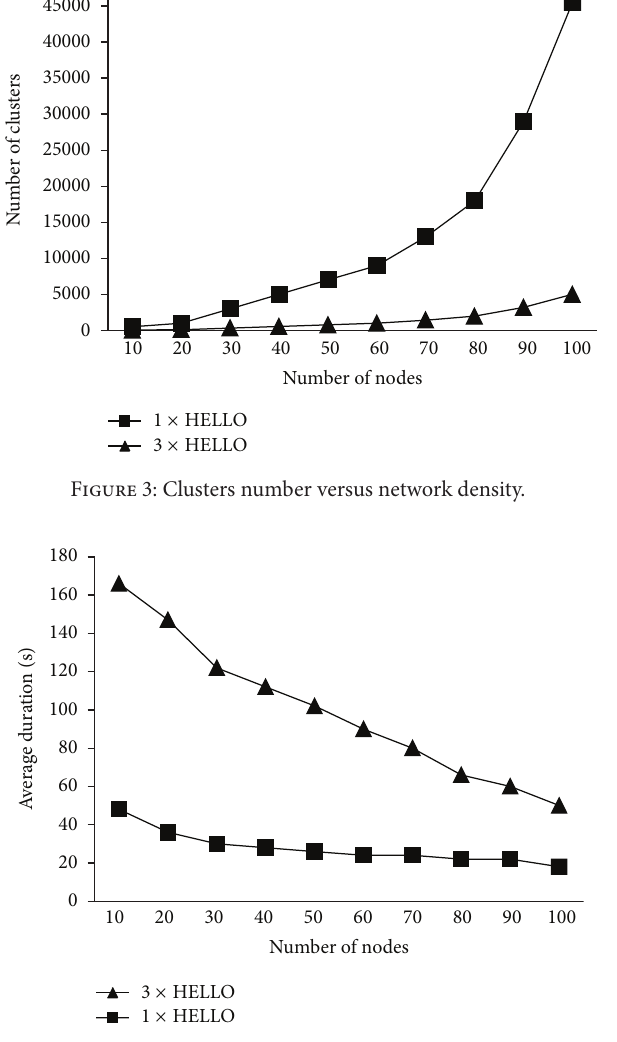
Figure 4: Clusters average duration versus network density.